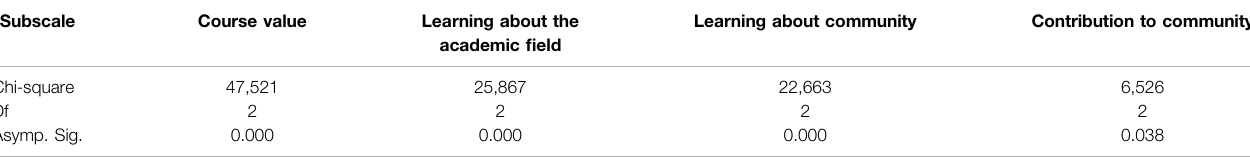
TABLE 5 | Comparative analysis of the students ’ assessment of the SL-based course between pairs of countries (Mann-Whitney U test). Countries compared Subscale Course value Learning about Slovakia vs. Romania